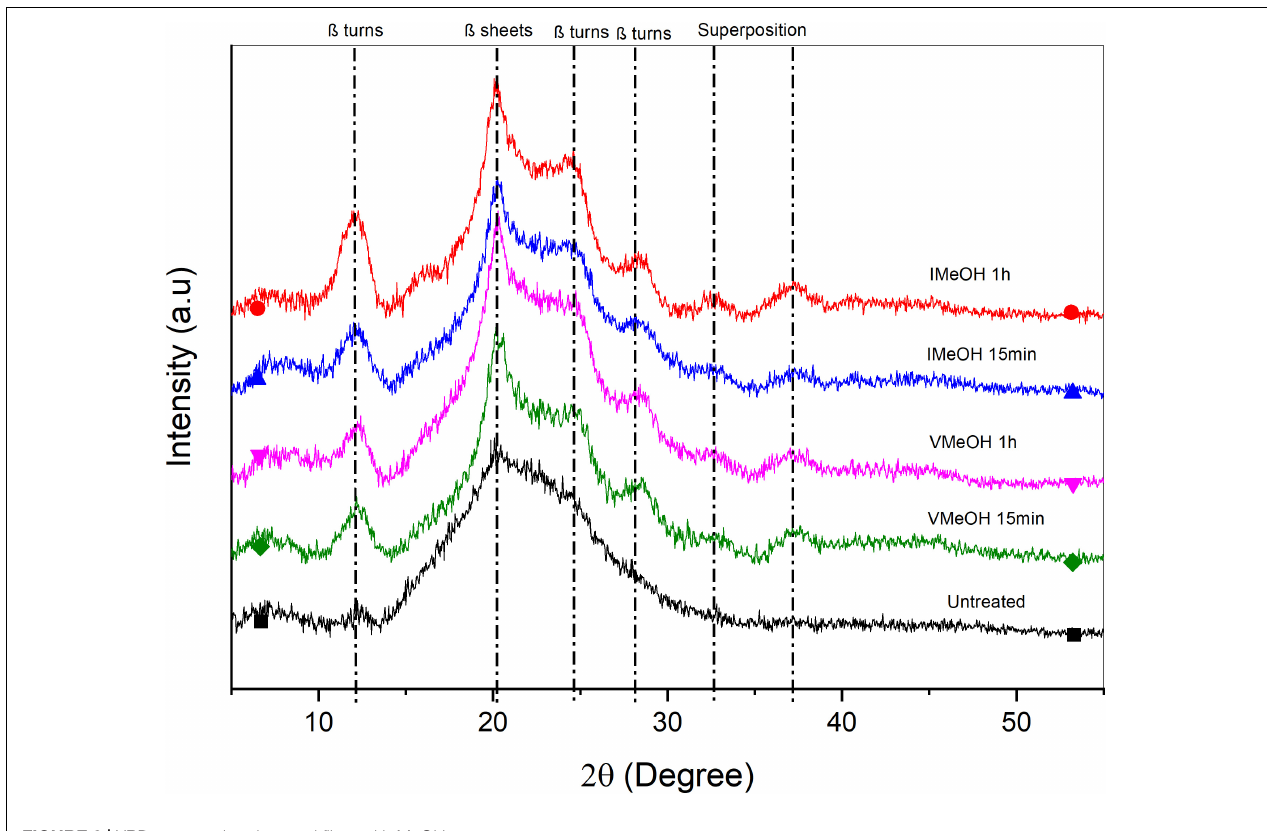
FIGURE 3 | XRD untreated and treated films with MeOH.